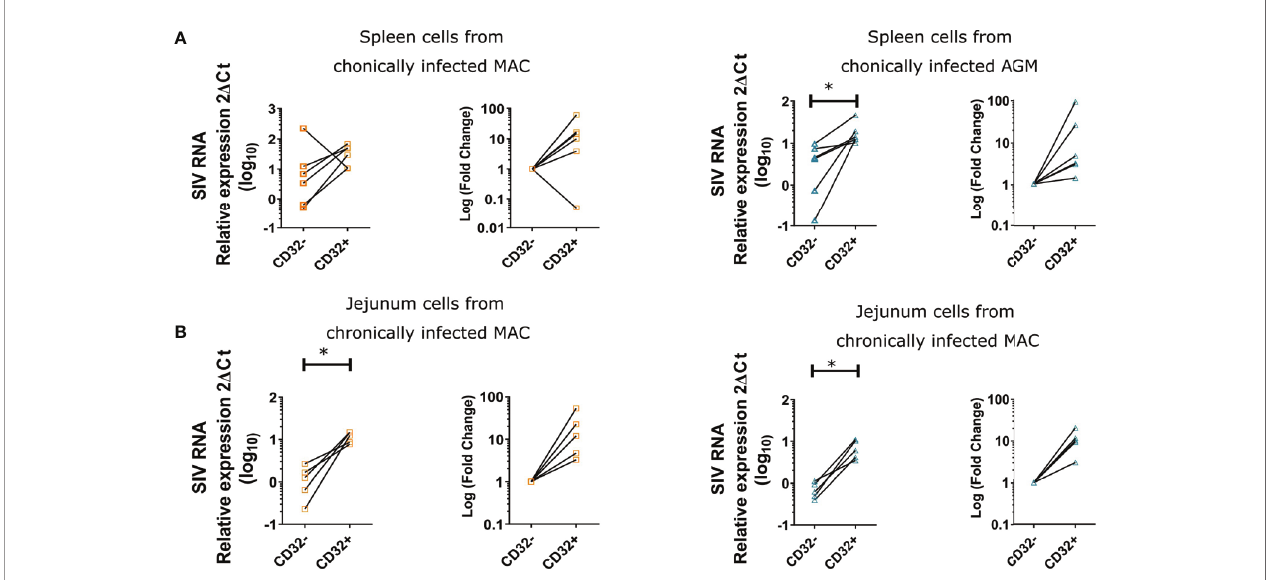
FIGURE 2 | Quanti fi cation of ca-SIV RNA in CD32+ and CD32- CD4+ T cells. Cells were isolated from (A) spleen and (B) jejunum of chronically infected MAC and AGM. Graphs show the ca-SIV RNA amount relative to 18sRNA (left graph) and the fold change in ca-SIV RNA in CD32 + cells compared to CD32 - CD4 + T cells (right graph) for each species. The amount of RNA in CD32 - cells of each respective tissue was arbitrarily set to 1. Orange symbols refer to MAC and blue symbols to AGM. Each symbol represents a single animal. Statistical difference was assessed by a Mann-Whitney U-test. Asterisks indicate p-values <